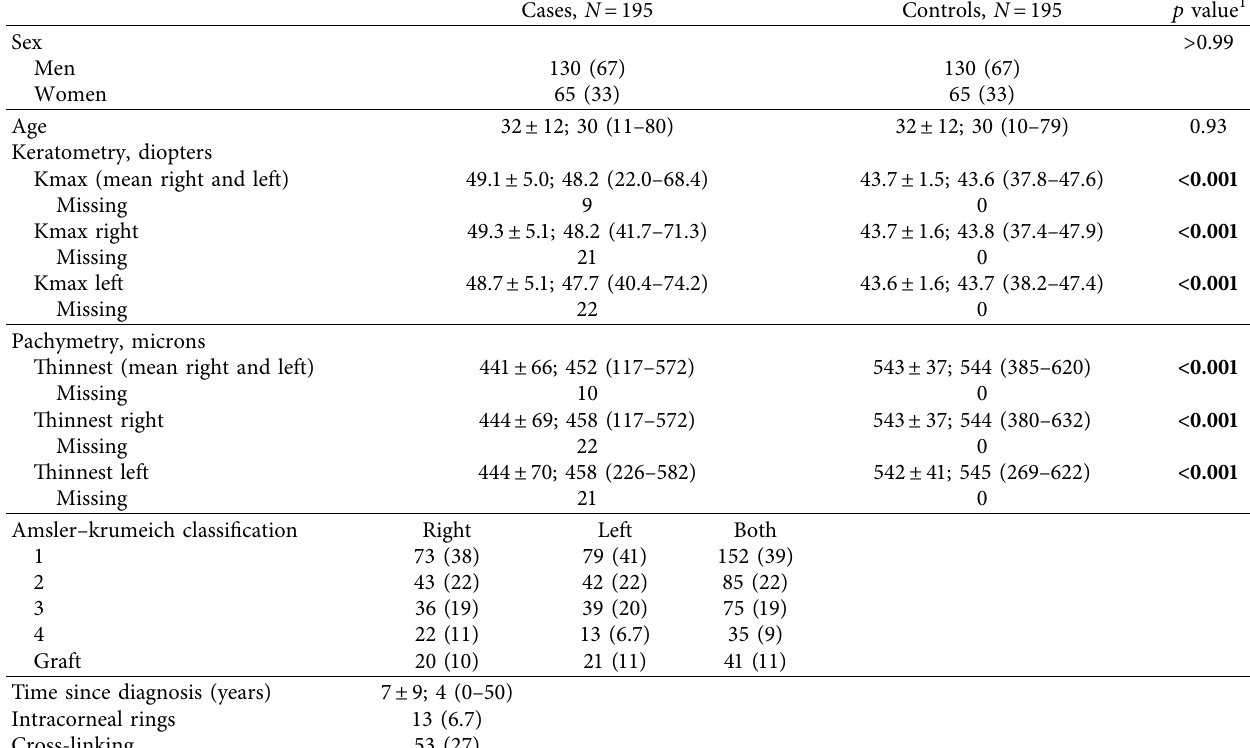
Table 1: Population